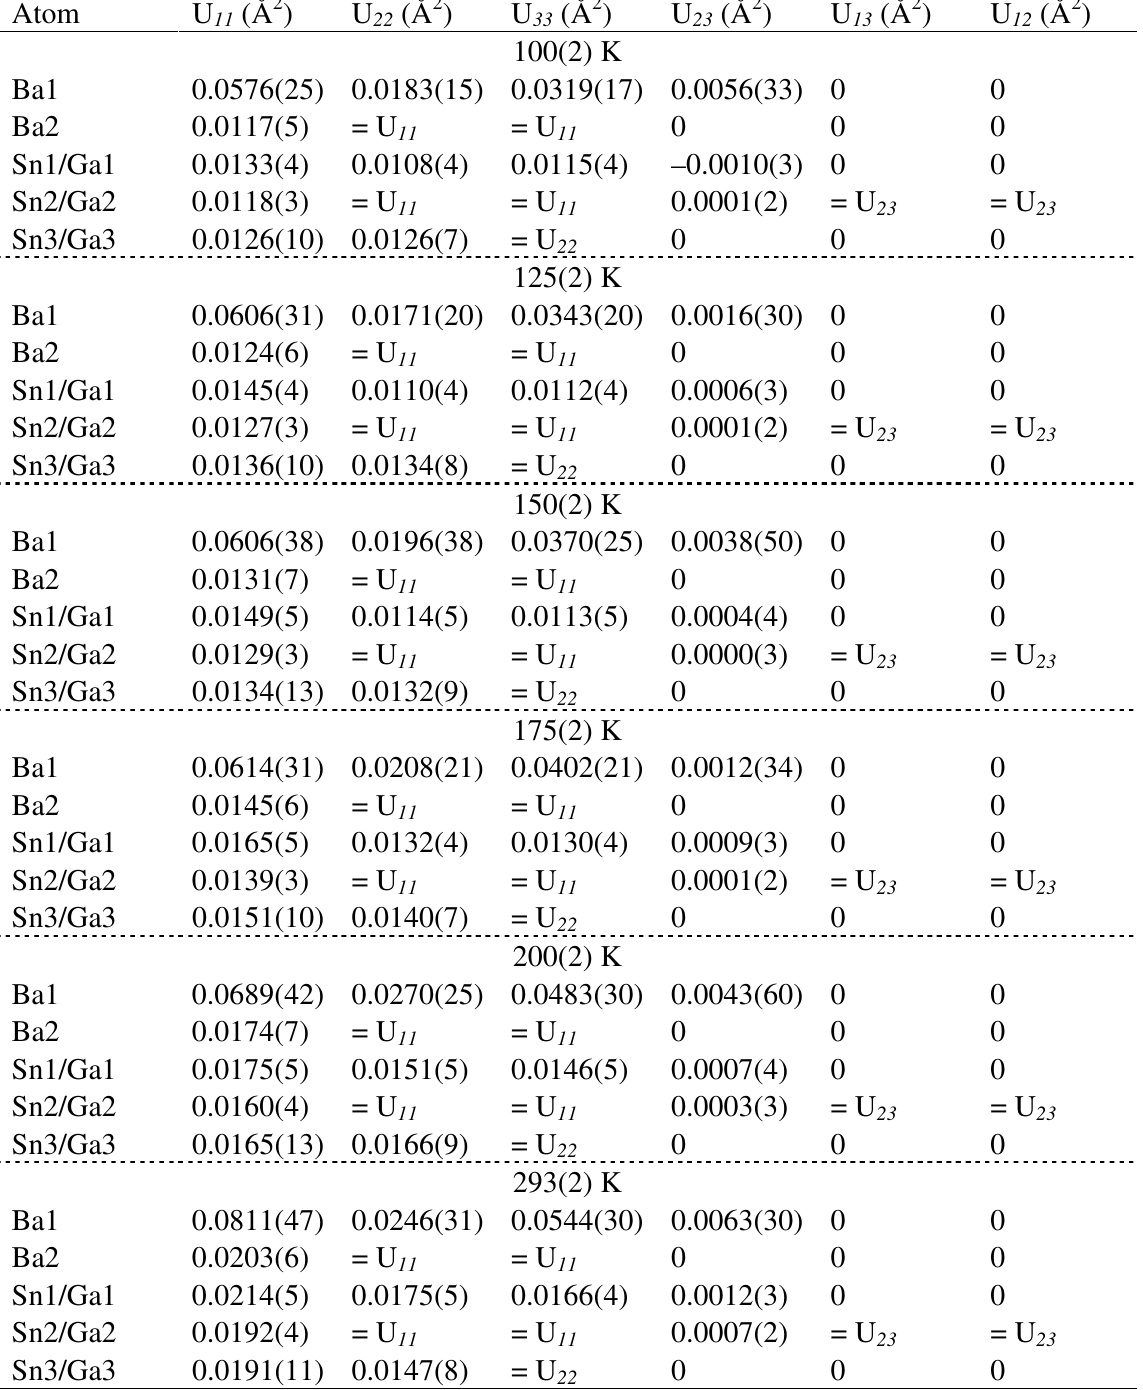
Table 4. Anisotropic displacement parameters (U at variable